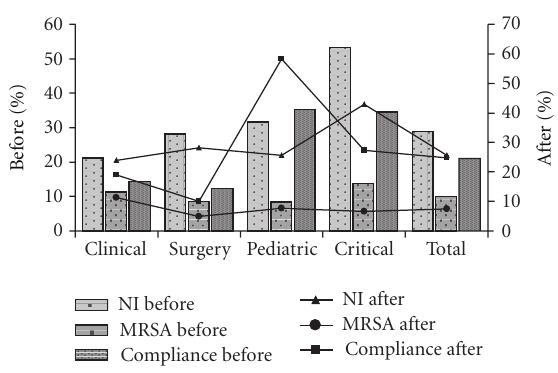
Figure 1: Epidemiological indicators distribution and compliance to hand hygiene in pre and post intervention in the Brazilian hos- pital. The bars represent the assessments in the period before the intervention and the lines after. NI: nosocomial infection; MRSA: methicillin resistant Staphylococcus